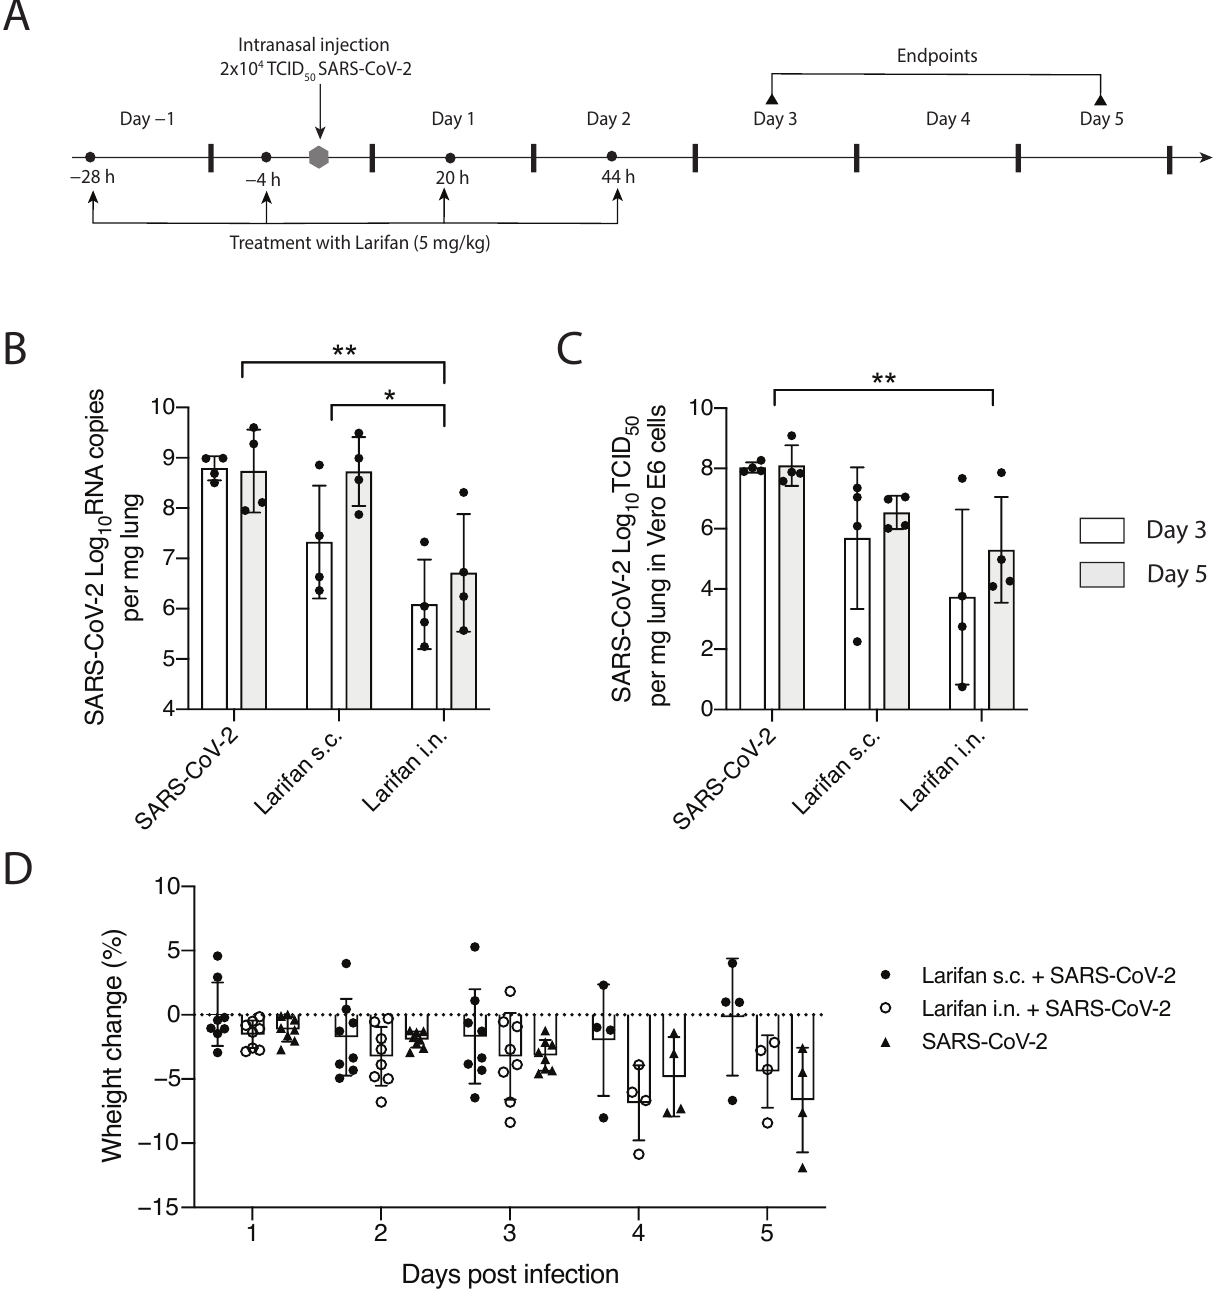
Figure 3. In vivo testing of Larifan’s effect in the SARS-CoV-2 infection model of golden Syrian hamsters. ( A ) Experimental strategy: hamsters were pre-treated with Larifan twice before virus infection, infected with SARS-CoV-2, and after infection treated two times more with Larifan always with an interval of 24 h between each administration. ( B ) Viral RNA copy number in the lungs of SARS-CoV-2 infected untreated and infected treated hamsters on days three and five after s.c. or i.n. Larifan administration. ( C ) Infectious virus titer in Vero E6 cells in the lungs of SARS-CoV-2-infected untreated and infected treated hamsters on days three and five after s.c. or i.n. Larifan administration. ( D ) Weight changes of SARS-CoV-2-infected untreated and infected Larifan-treated hamsters during the study. Data presented as mean ( ± SD). Statistical significance analysis was performed by using two-way ANOVA. * p < 0.05, ** p < 0.01. Dots represent individual